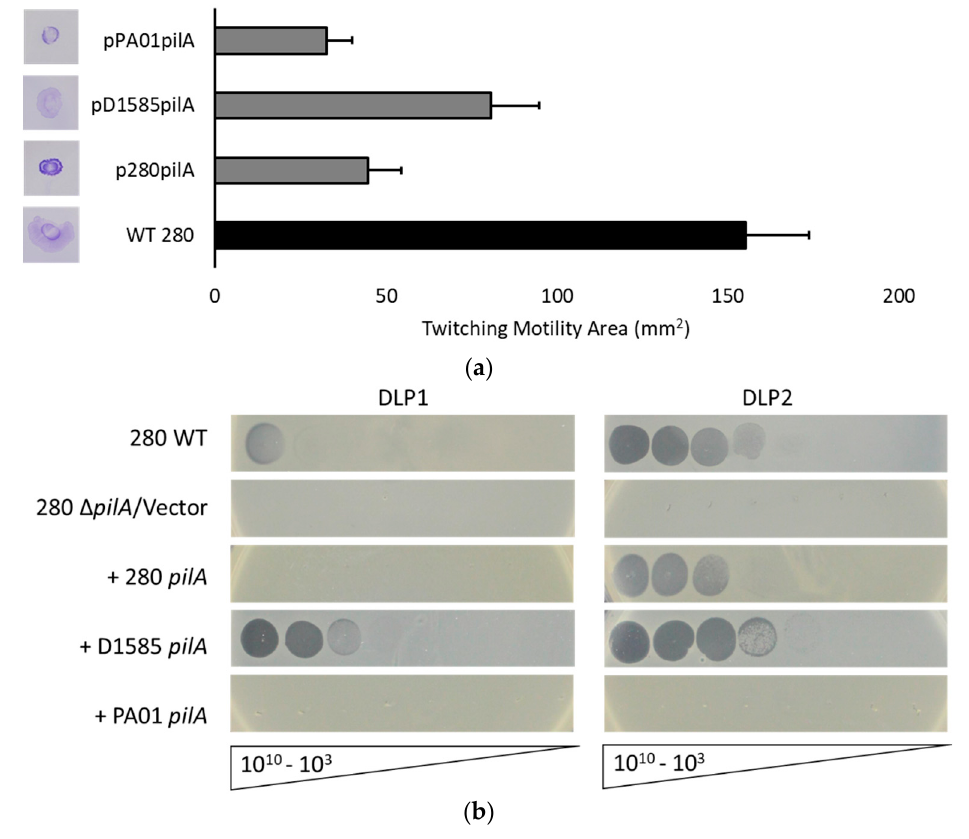
Figure 5. Infection of S. maltophilia 280 expressing varying pilin subunits by DLP1 and DLP2. ( a ) Twitching motility of the 280 Δ pilA mutant complemented with the PA01, D1585 or endogenous 280 pilA is not restored to wildtype levels and is not correlated with phage susceptibility. Representative twitching zones are shown on the left and the average area of the twitching zones from nine replicates are shown on the right. ( b ) 280 wildtype (WT) is susceptible to DLP2, while the 280 Δ pilA mutant is resistant. Complementation of 280 Δ pilA with the endogenous pilA gene restores DLP2 infectivity to near wildtype levels, plaquing at 10 7 PFU/mL. Cross-species complementation with the S. maltophilia D1585 pilA gene restores DLP2 infectivity to wildtype levels, plaquing at 10 5 PFU/mL, and allows partial DLP1 infectivity, showing plaquing at 10 8 PFU/mL. Cross-genera complementation with the P. aeruginosa PA01 pilA gene does not restore phage infection. Images are representative of three biological replicates, each with three technical replicates.